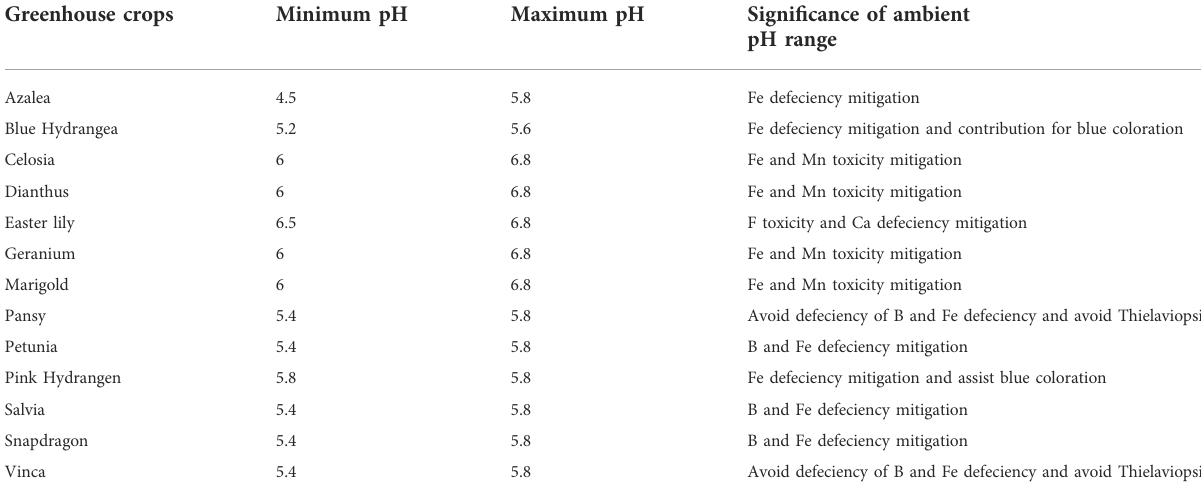
TABLE 3 Allowable pH ranges for signi fi cant greenhouse